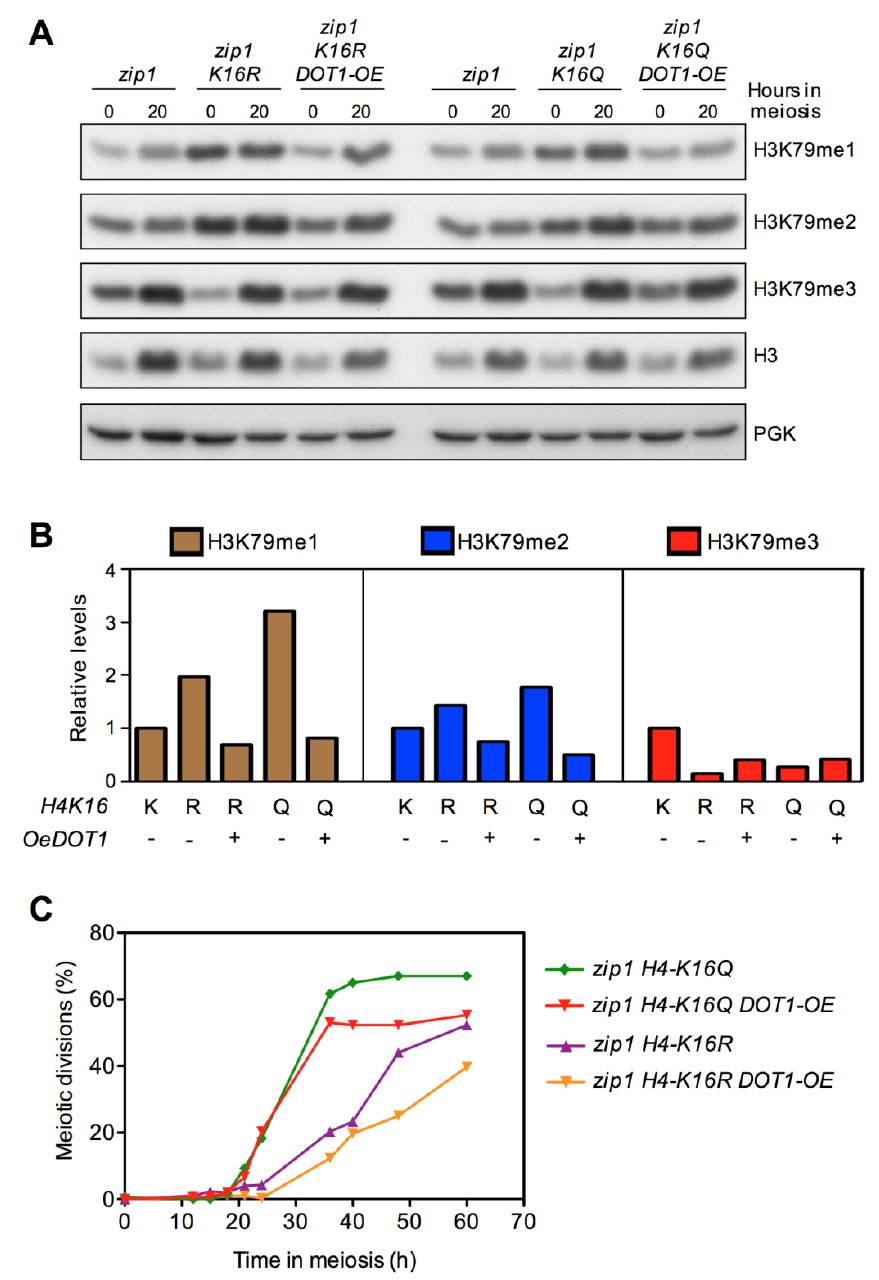
FIGURE 7: DOT1 overexpression partially restores the meiotic check- point in H4K16ac-deficient mutants. (A) Western blot analysis of H3K79 methylation species in vegetative (T=0h) and meiotic cells (T=20h). Total H3 and PGK were used as load- ing controls. (B) Quantification of relative levels of the H3K79 methyla- tion forms at T=0 from the blots shown in (A). Total H3 signal was used for normalization. (C) Time course of meiotic nuclear divisions; the percentage of cells with two or more nuclei is presented. Strains are DP422 ( zip1) , DP995 ( zip1 H4-K16R ) and DP1001 ( zip1 H4-K16Q ), trans- formed either with an empty vector or with the high-copy pSS63 DOT1 overexpression plasmid ( DOT1-OE